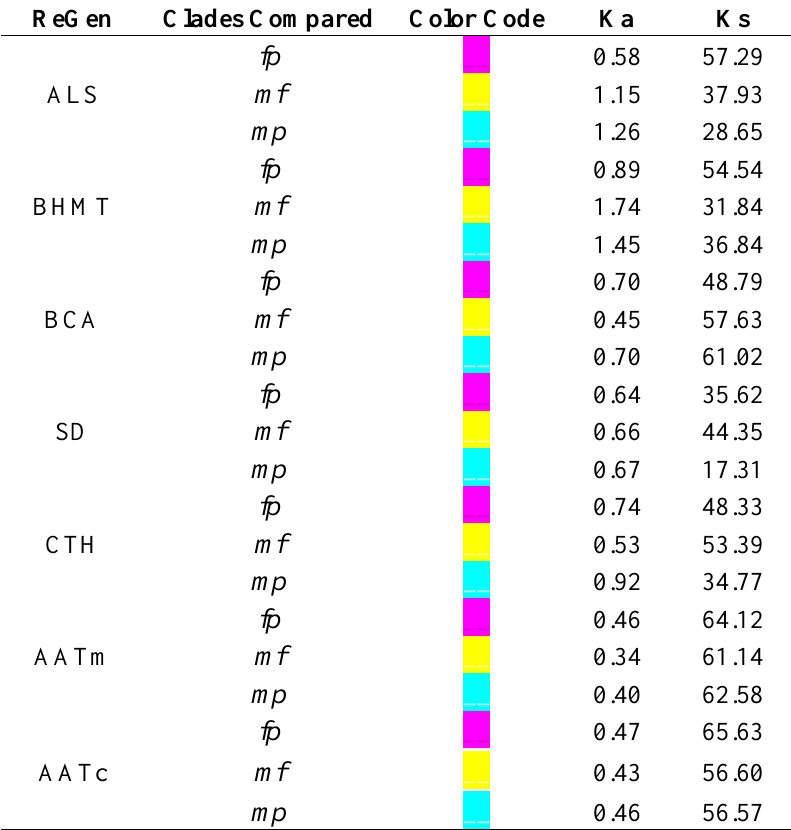
Table 4. Ka/Ks ratio as calculated by